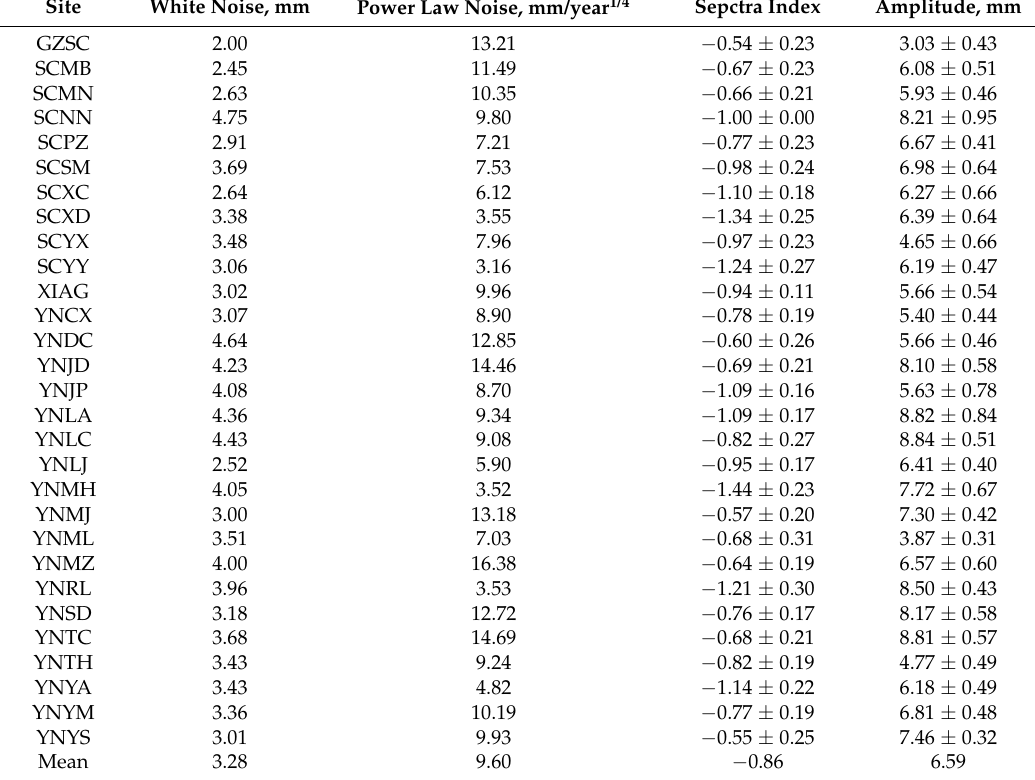
Table 1. White noise, Power law noise, spectral index, and annual amplitude estimates for the vertical component of the 29 GPS time series, and the power law noise is scaled to mm/year 1/4 for comparison’s sake. As Hector program produces unreliable results at SCNN sites when the spectral index is not fixed, so does another program CATS V3.1.2 [40], so the parameters and noise at SCNN are estimated with fixed spectral index −